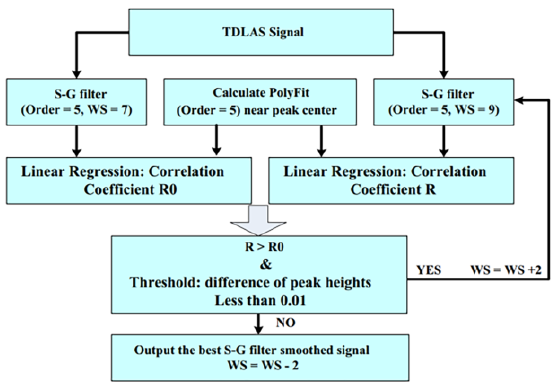
Figure 5. Flow chart of adaptive Savitzky–Golay algorithm. This figure was adopted from [41].